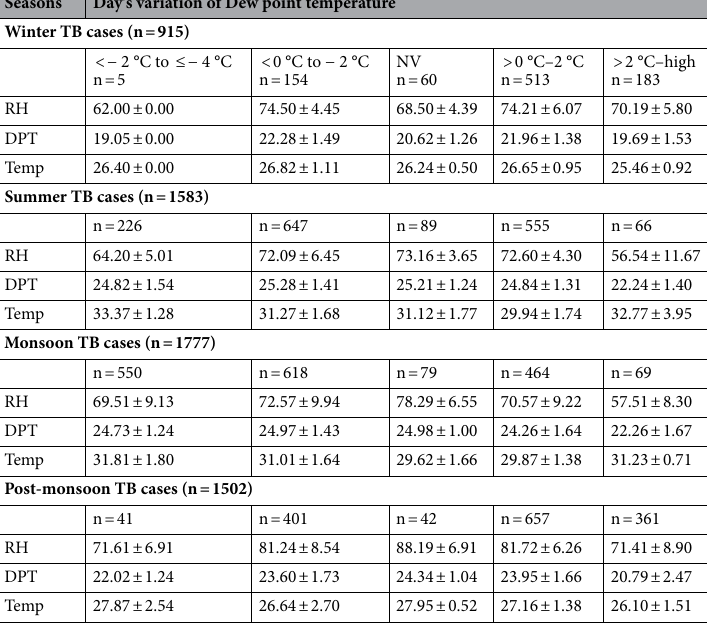
Table 1. Seasonal variation and TB notification respective days Dew point